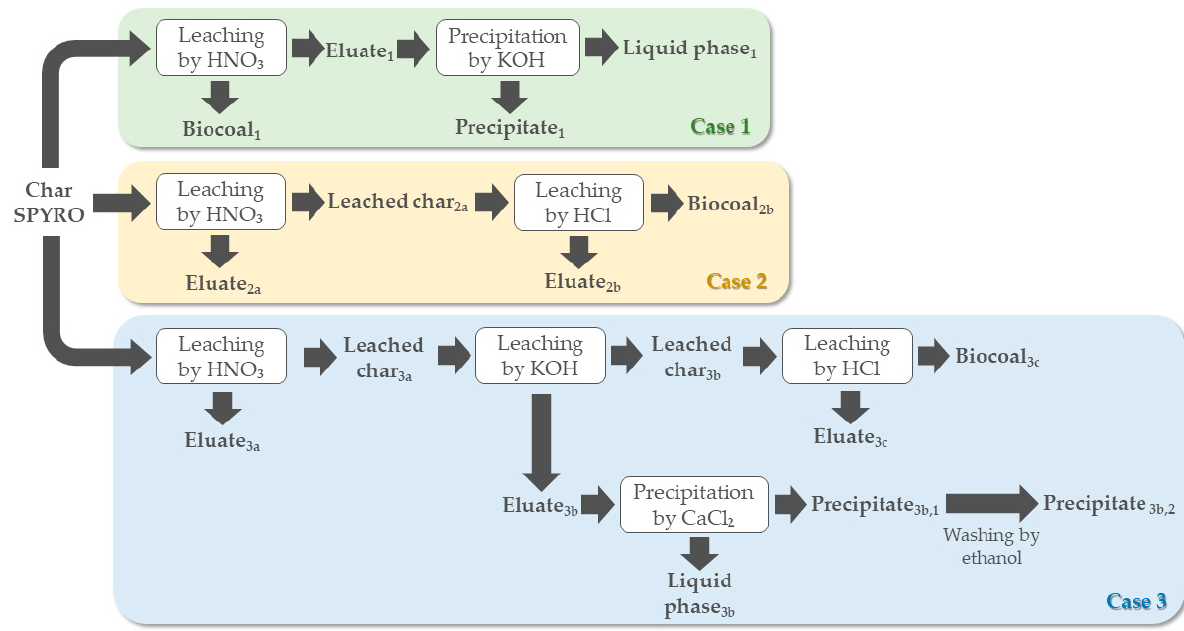
Figure 2. Case 1, case 2, and case 3 process schemes.